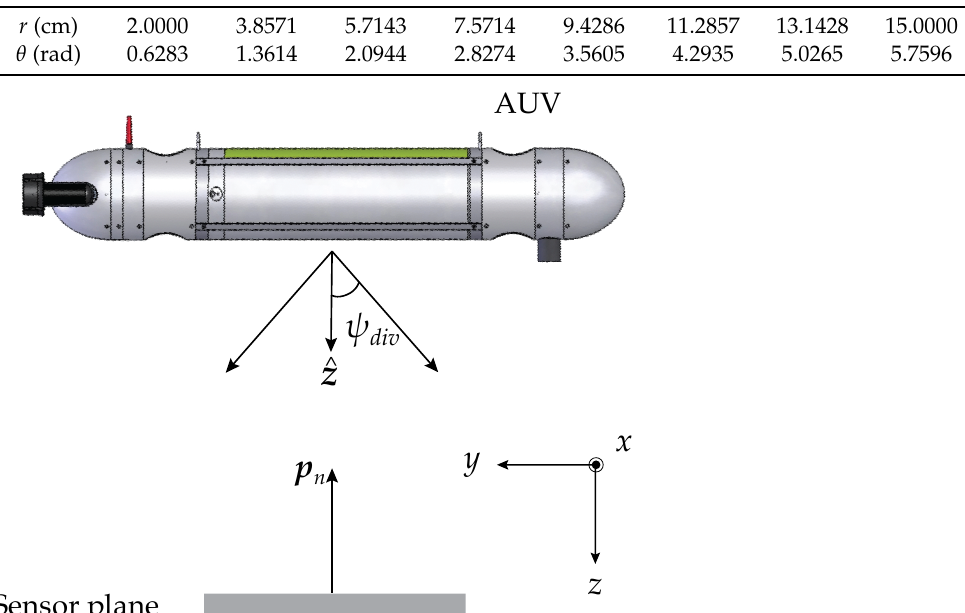
Table 4. Grid of 8 × 8 points in space used for testing the algorithm, estimating the offset between the transmitter and receiver.